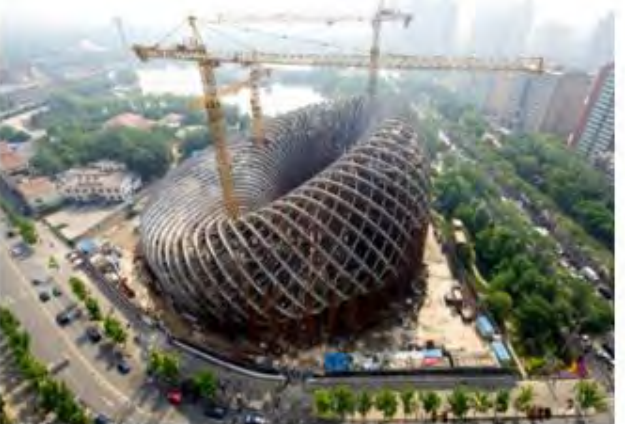
Figure 16. Phoenix InternationalMedia Center. Source (”Phoenix International Media Center”,